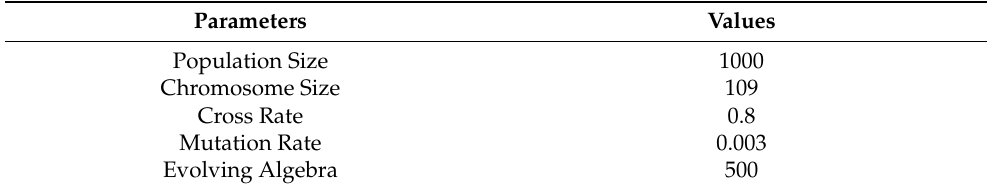
Table 2. Values of parameters in